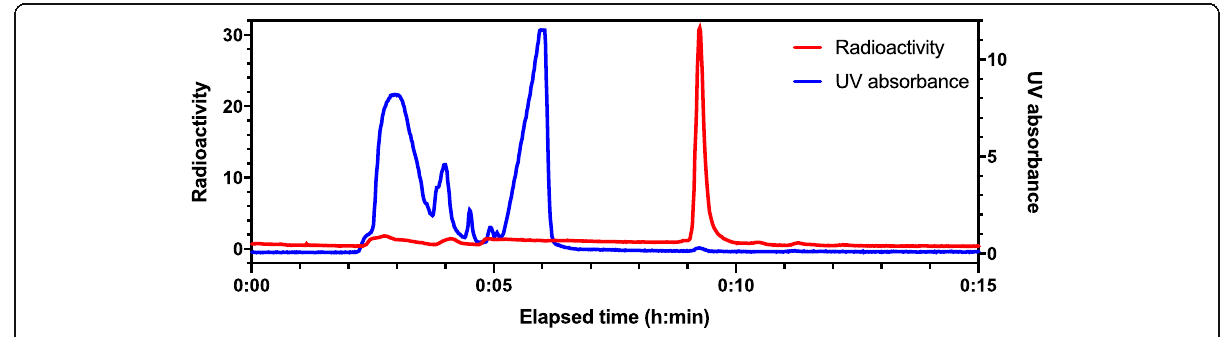
Fig. 3 Representative preparative HPLC chromatogram of the reaction